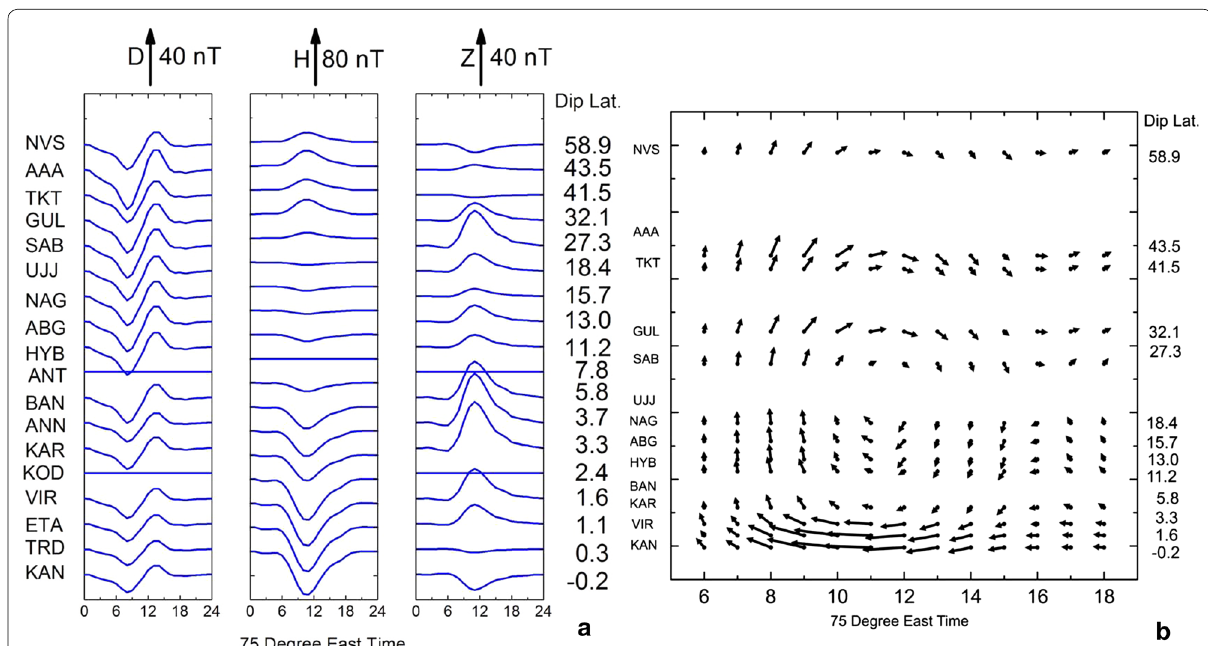
Fig. 4 a Residual fields of CEJ and NEJ days for D-, H-, and Z-components corresponding to PC-1 along the Indo-Russian chain of stations, showing the CEJ effect at equatorial stations extending up to BAN. b Plots of equivalent current vectors on the local time latitude sector for PC-1 (for the residual field) during a CEJ day (January 23, 1992) with the focus between UJJ and SAB (~20° dip